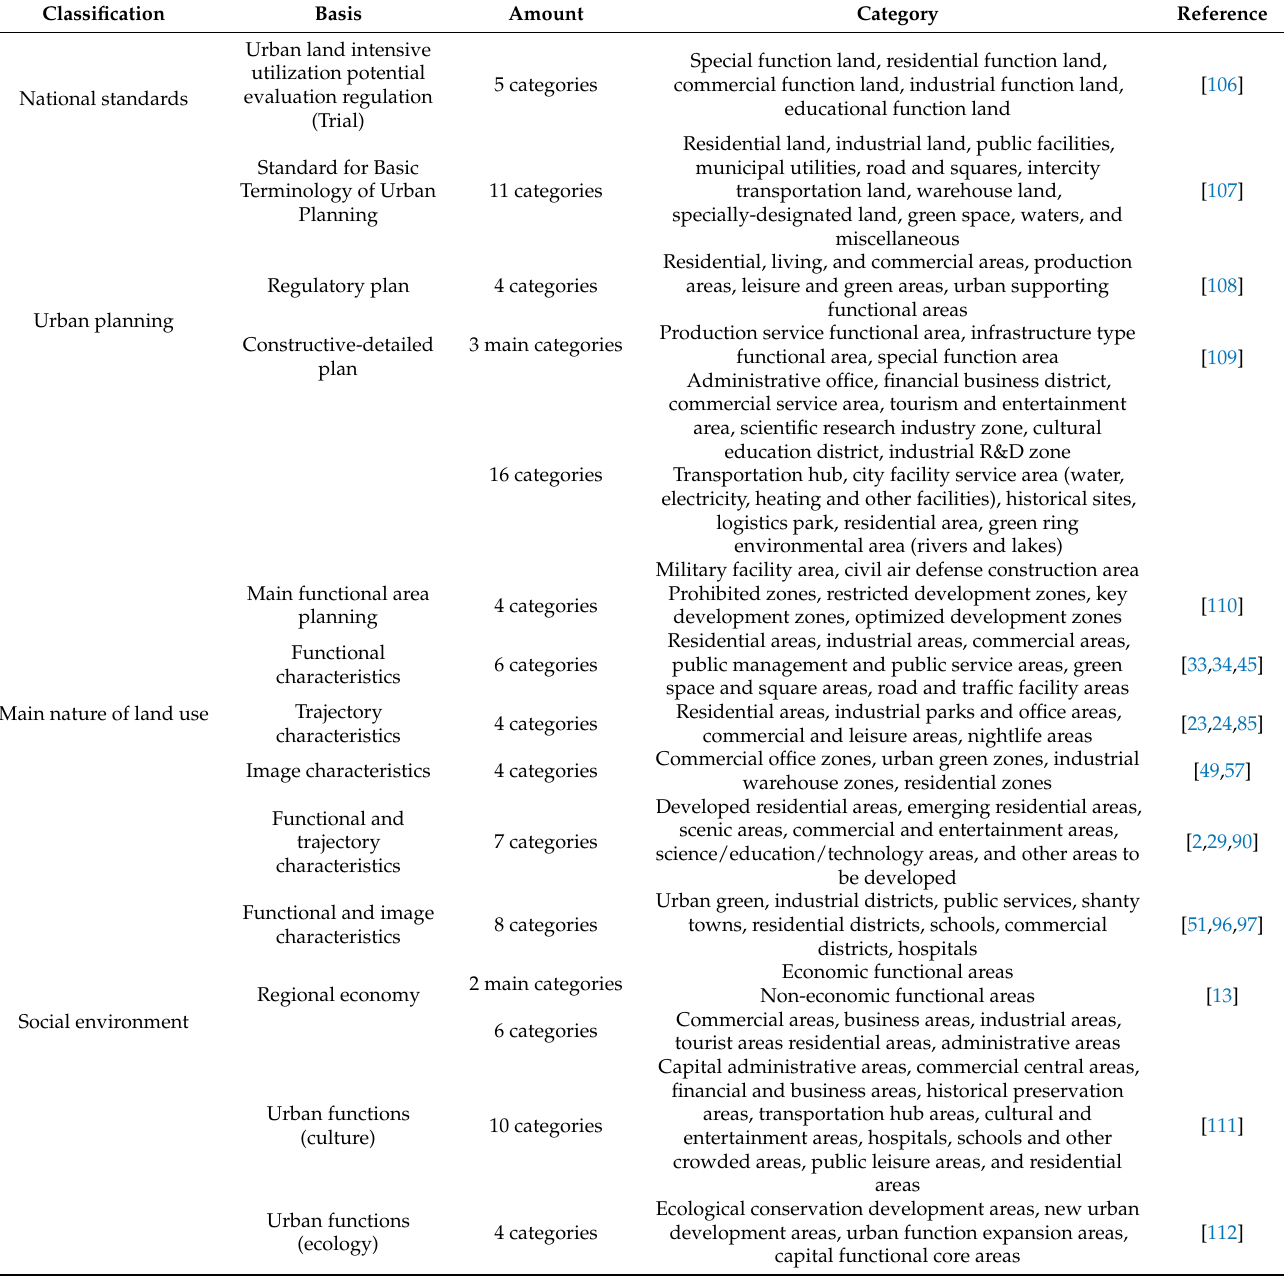
Table 2. General classification schemes of urban functional